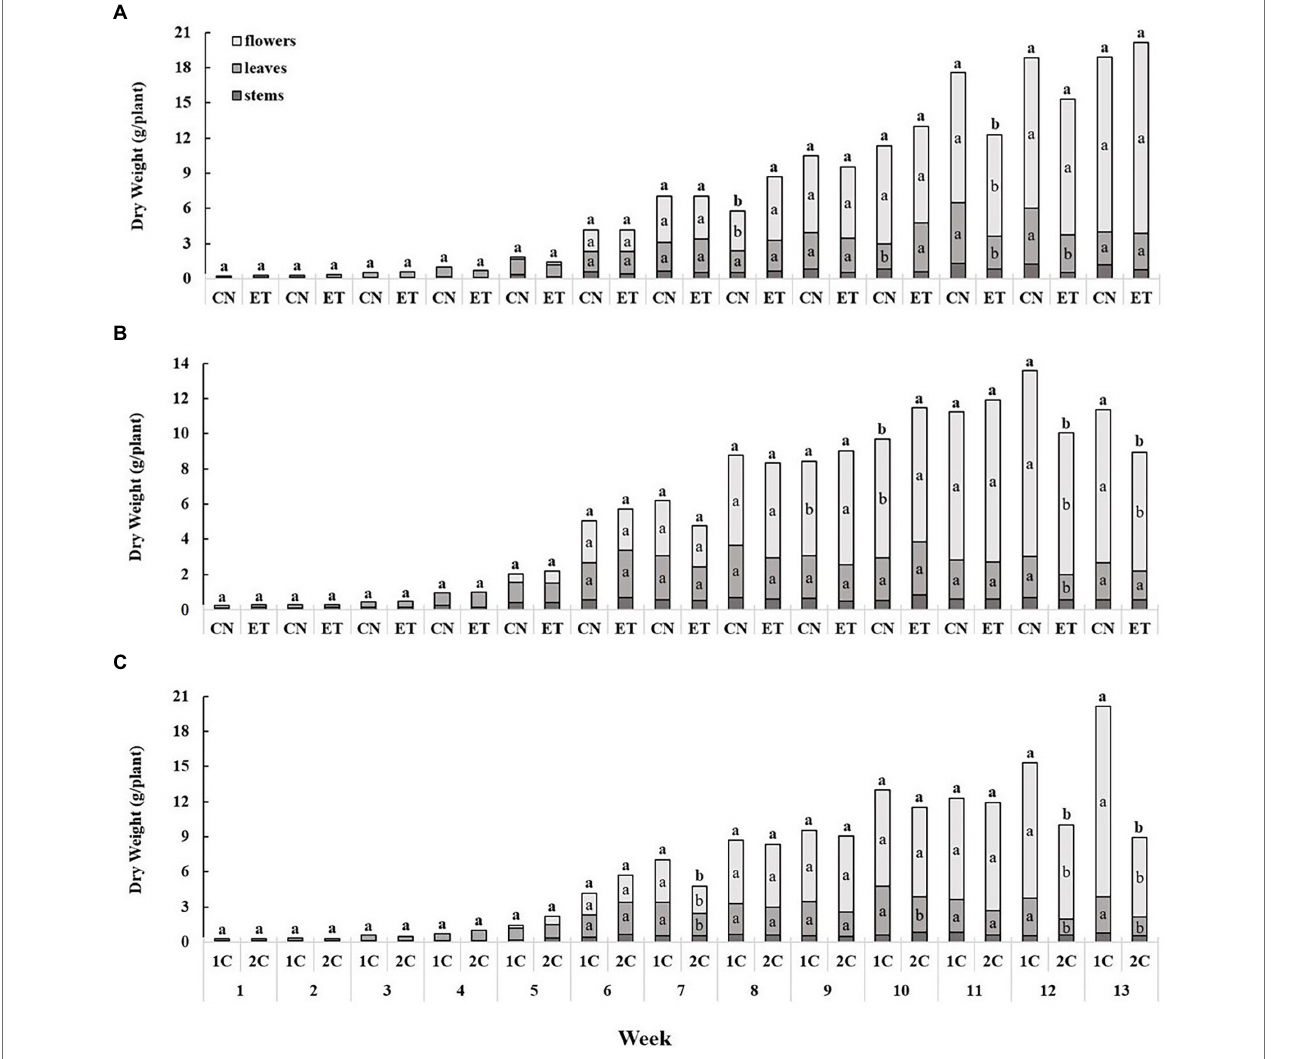
FIGURE 6 | The effect of amino acid supplementation (AAs) and growing nutritional cycle on medical cannabis plant biomass. Dry biomasses of stems, leaves, and flowers in control (CN) and enhanced treatment (ET) plants with AAs nutritional supplements in recirculation (1C) growing cycle (A) , in drain-to-waste (2C) growing cycle (B) , ETs in 1C and 2C (C) . Data are means ± SE ( n = 3). The different small letters inside the bars and small bold letters above the bars represent significant differences within the medical cannabis plant organs (leaves and flowers) and the whole plant biomass between the variants in a particular week according to Tukey’s HSD test at α =